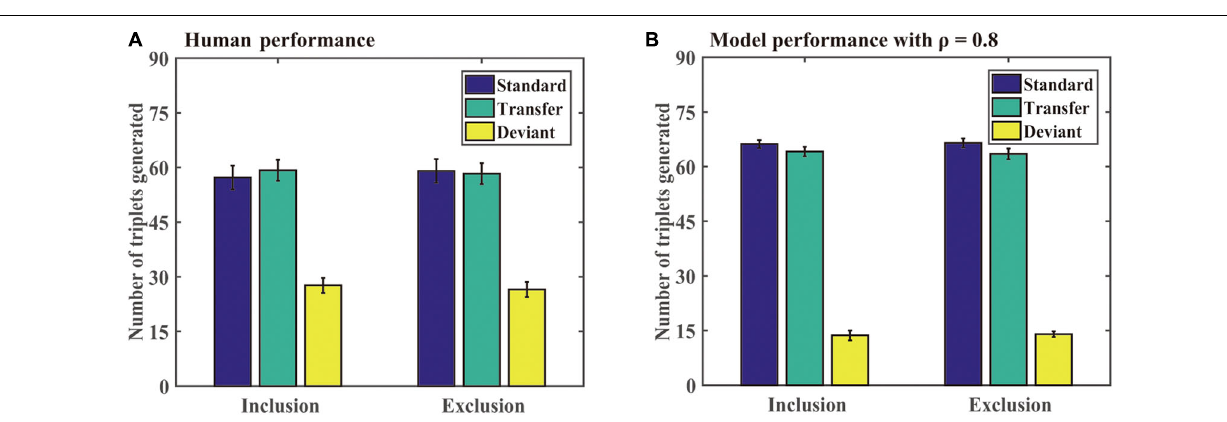
FIGURE 8 | Human and model performance under inclusion and exclusion tests in Simulation 3. (A) The number of triplets generated by human participants. (B) The number of triplets generated by